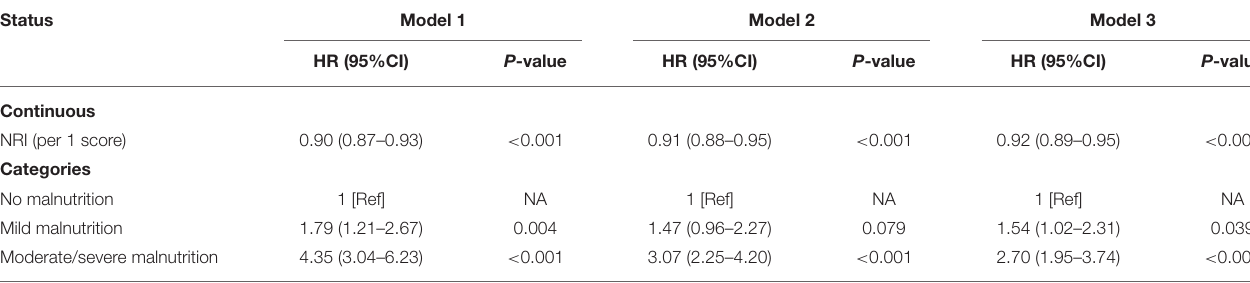
TABLE 2 | All-cause mortality hazard ratios (HRs) for participants aged 20 years and older according to malnutrition